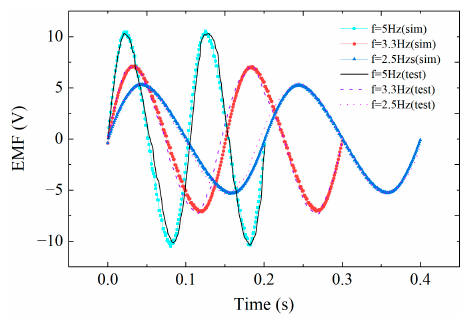
Figure 12. Harmonic distribution of EMF under different strokes.